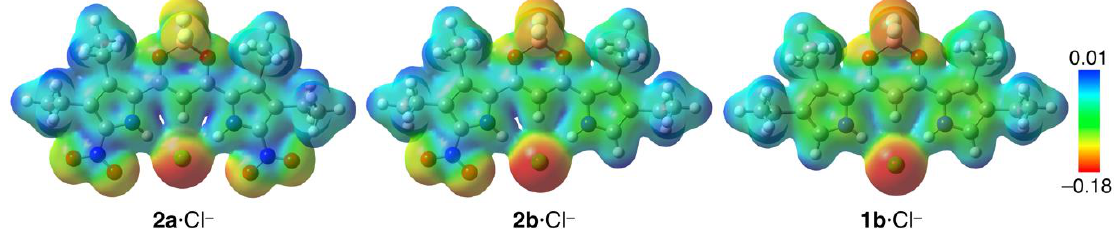
Figure 6. ESP mapped on the electron density isosurfaces (δ = 0.01) of 2a , b ·Cl − and 1b ·Cl − at the B3LYP-6-31+G(d,p) level.